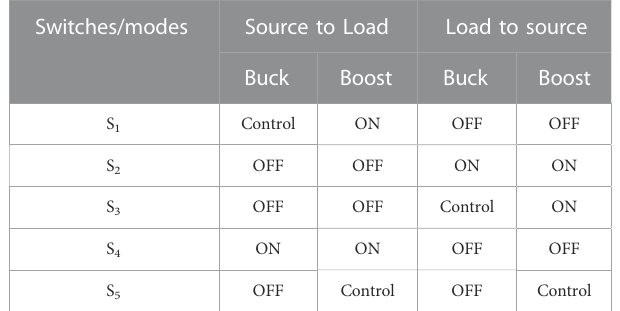
TABLE 2 Modes of the